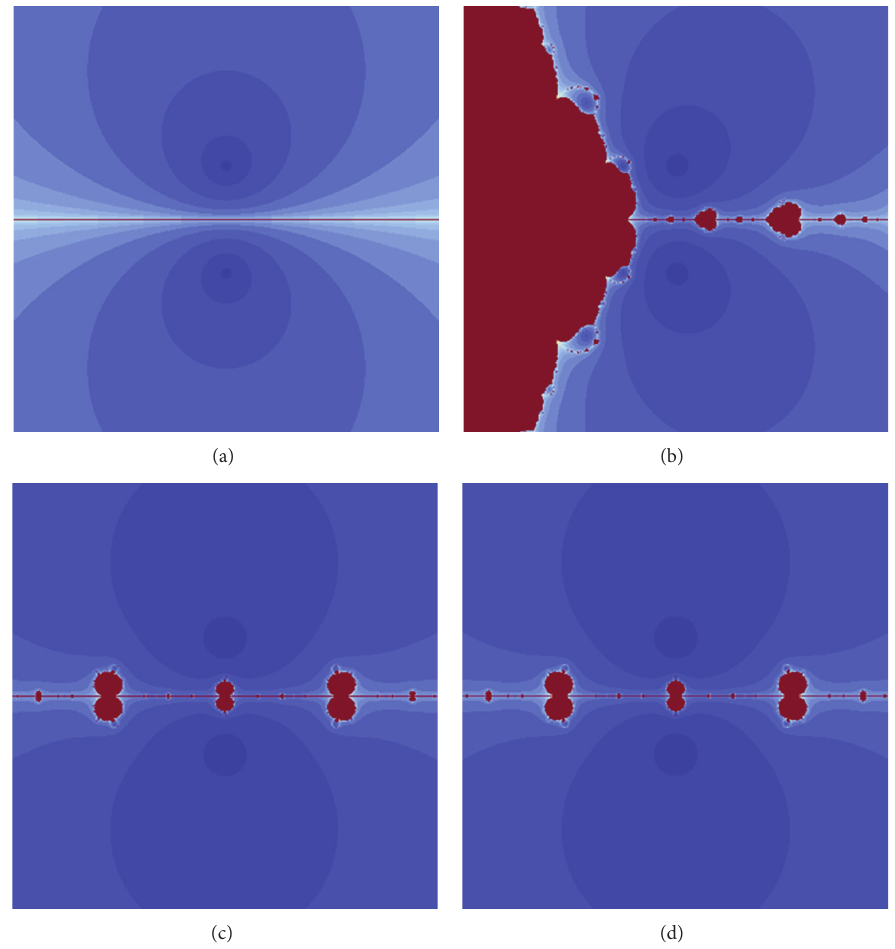
Figure 2: Fractal behavior for the rational function associated to the Steffensen’s method with 𝛽 = 0.01 (a), Jain’s method (b), (3) with 𝛽 = 0.01 (c) and (3) with 𝛽 = 0.0001 (d) for 𝑓 : 𝑧 → 𝑧 2 + 1 . Shading according to the number of